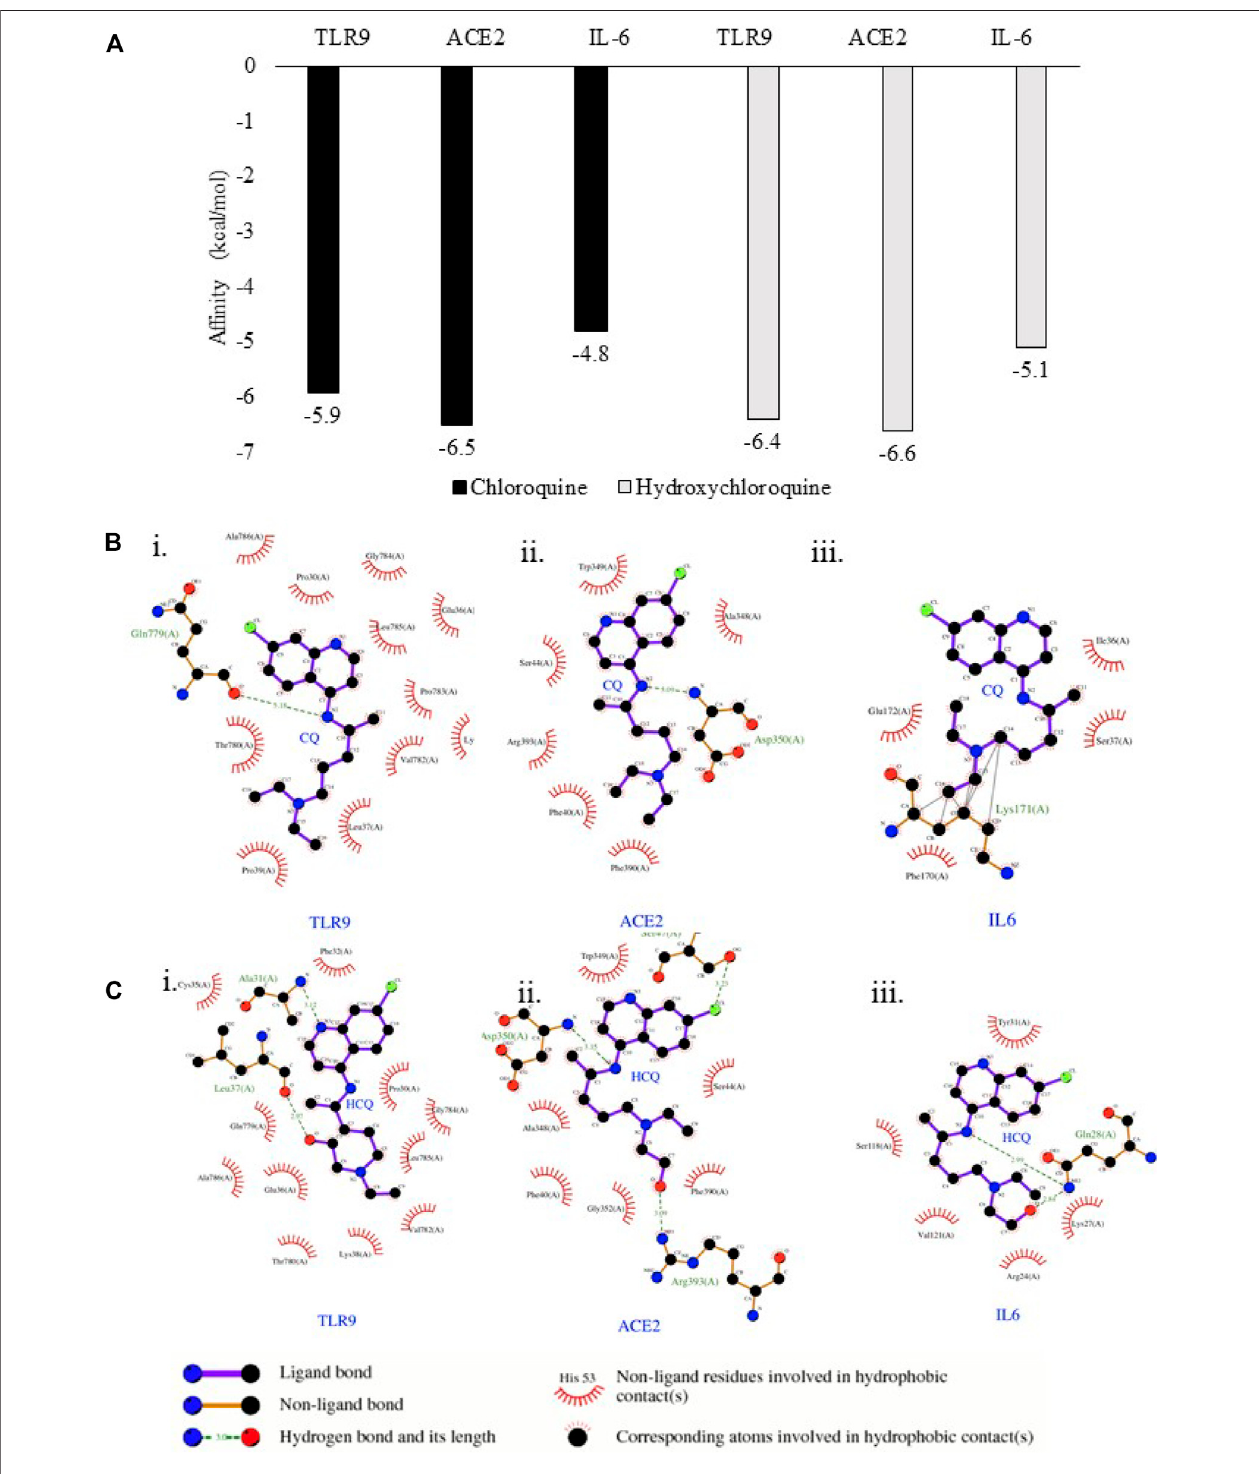
FIGURE5| TLR9andIL-6exhibitedbindingaf fi nitytoCQandHCQ. (A) PredictedfreeenergyofbindingofCQandHCQwithTLR9,IL-6andACE2wereshownby Autodock Vina. (B) The output of molecular docking showing the binding site residues of protein targets (TLR9, ACE2 or IL-6) with the ligand CQ. (C) The output of moleculardockingshowingthebindingsiteresiduesofproteintargets(TLR9,ACE2orIL-6)withtheligandHCQ.Thedashed linesrepresentintermolecularinteractions.